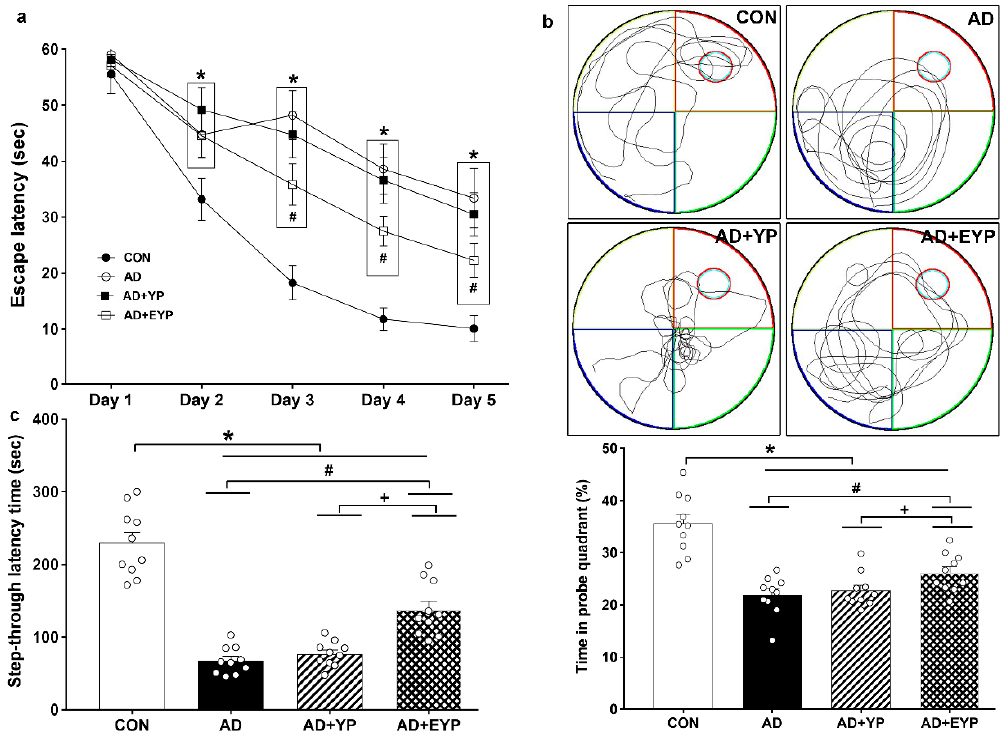
Figure 2. Effect of plasma from young exercised mice on cognitive functions in 3xTg-AD mice. The Morris water maze task for spatial learning ( a ) and memory ( b ) and step through task for long-term memory ( c ). CON: wild-type, AD: 3xTg-AD, AD + YP: 3xTg-AD and young plasma injection, AD + EYP: 3xTg-AD and exercised young plasma injection group. Data are expressed as the mean ± standard error of the mean (SEM). * p < 0.05 compared with the CON group. # p < 0.05 compared with the AD group. + p < 0.05 between AD + YP and AD + EYP groups.